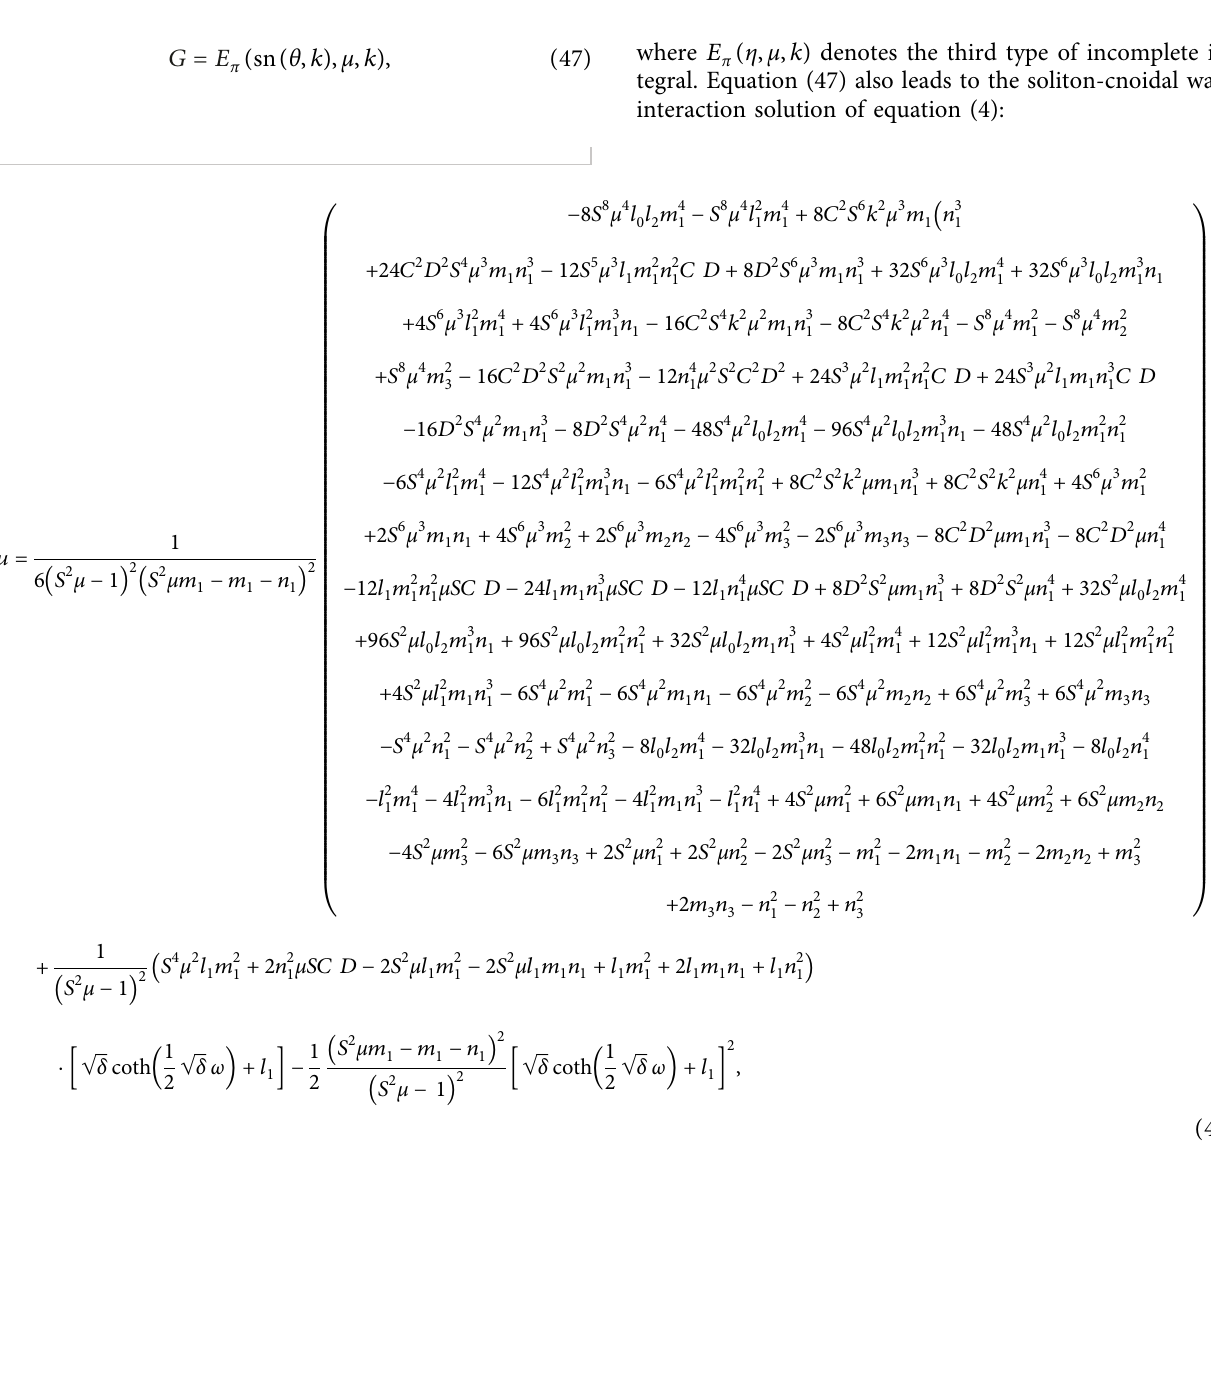
Figure 3: Evolution of equation (43) at different times. (a) Perspective view of the wave at t � − 5. (b) Perspective view of the wave at t � 0. (c) Perspective view of the wave at t �